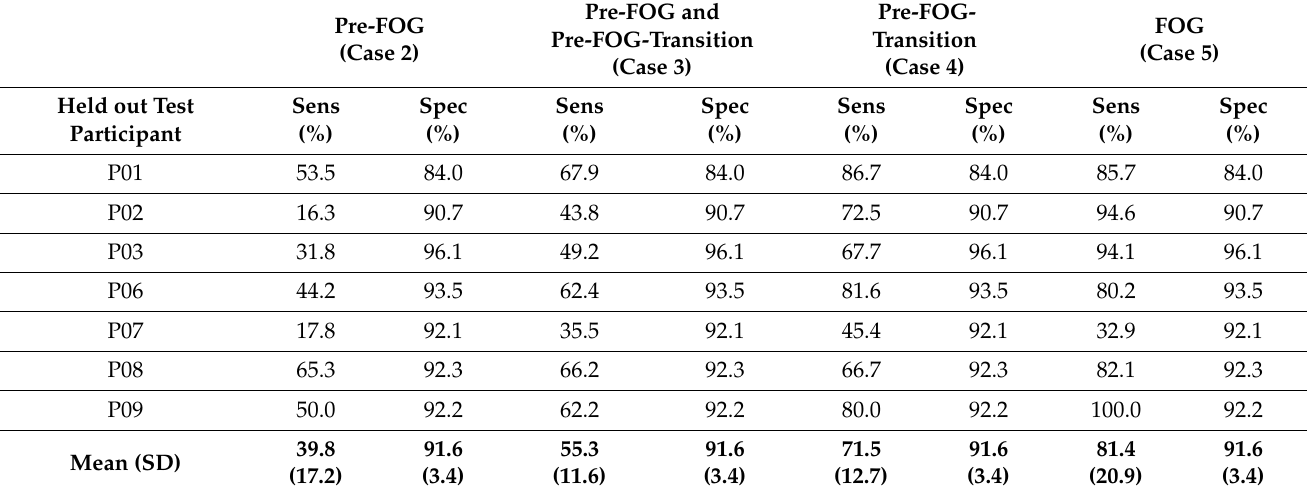
Sens: sensitivity, Spec: specificity. Table 8. Target class test cases for IMU features model, using top 25 features according to minimum-redundancy maximum- relevance (mRMR). Column headers are the label(s) included in the target class, as defined in Table